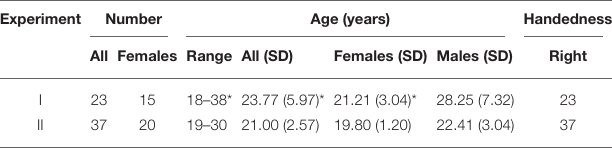
TABLE 1 | Demographic data of participants included in data